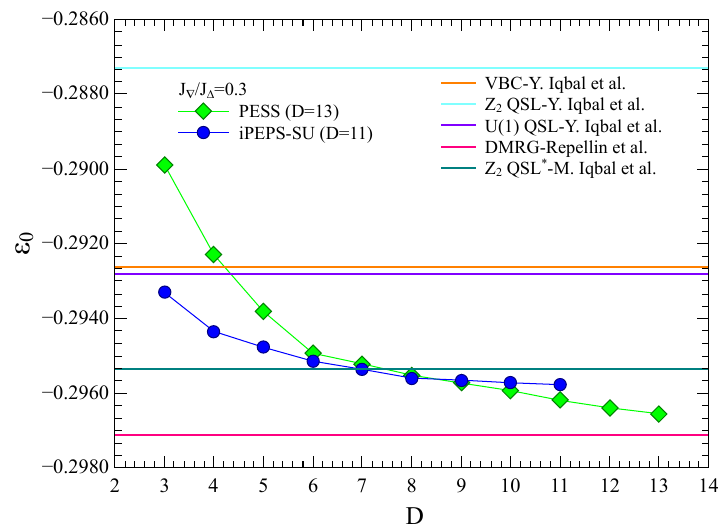
Figure 4: (Color online) Scaling of the ground-state energy, (cid:34) dimension D at J (cid:53) / J (cid:52) = 0.3. The power law scaling of energies with respect to D is similar to the isotropic point, J (cid:53) / J (cid:52) = 1, suggesting that both points belong to the same